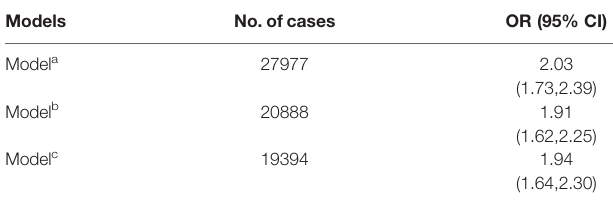
TABLE 2 | ORs (95% CIs) of overweight or obesity-hypertension association (normal BMI as the reference) from the GEE models. Models